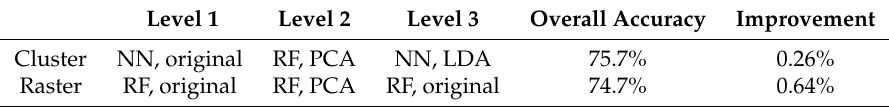
Table 3. Next place prediction accuracies when using the best prediction model on each